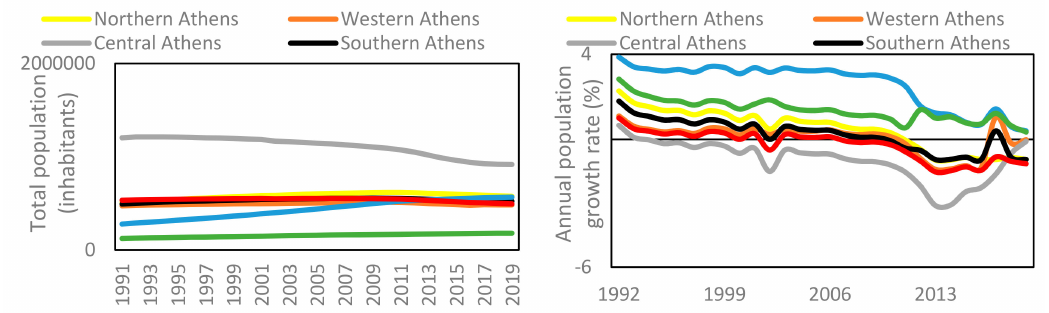
Figure 8. Total population (inhabitants) ( left ) and annual percent rate of population growth ( right ) by regional unit in the study area